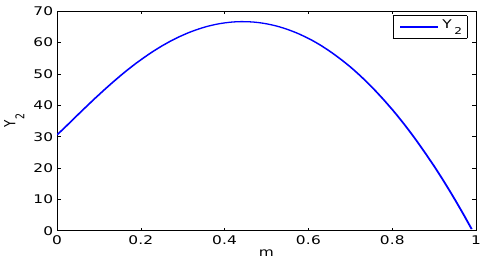
Figure 11: Bifurcation diagram of the predator species of model (1.4), m as the bifurcation parameter.